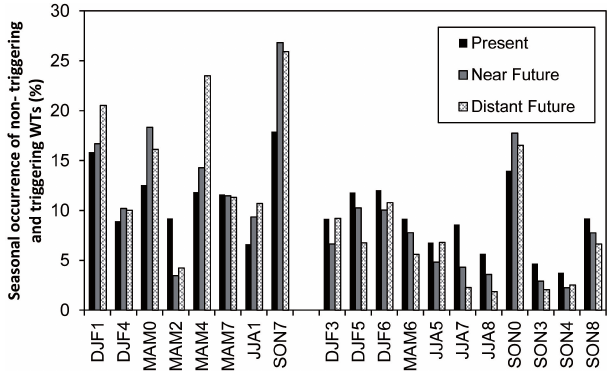
Fig. 10. Evolution of the seasonal occurrence of non-triggering and triggering-WTs under the ARPEGE scenario.